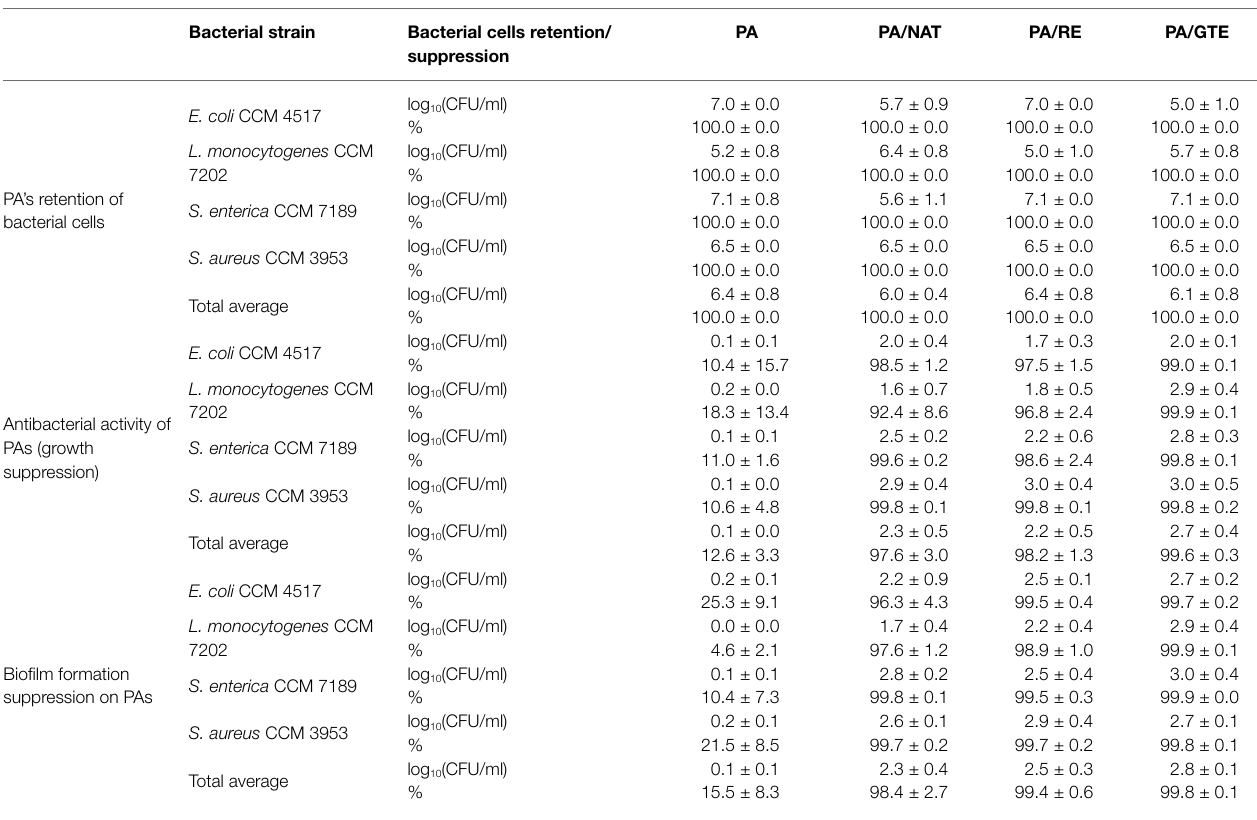
TABLE 3 | Retention of nanomaterials when filtering bacterial suspensions expressed as log 10 removal (CFU/ml) and %; antibacterial activity of nanomaterials relative to the control—bacterial suspension alone—and expressed as a bacterial growth suppression in log 10 (CFU/ml) and %; biofilm formation on nanomaterials related to